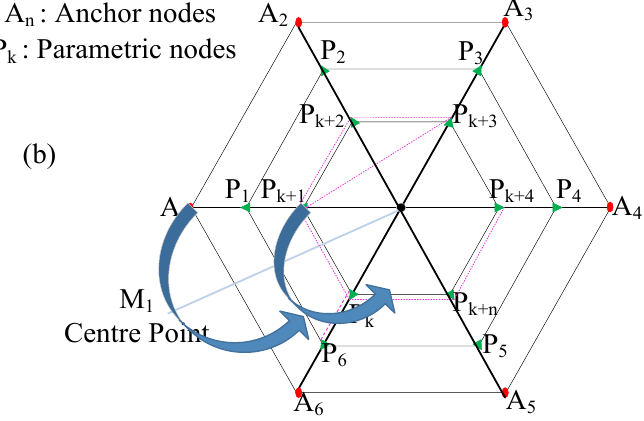
Figure 2. Parametric point calculation in PLD